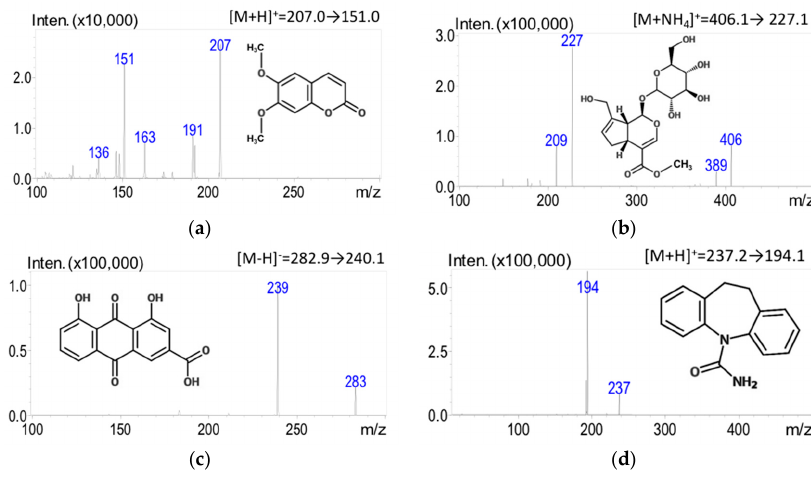
Figure 1. Chemical structures of the analytes and the product ion mass spectra and fragments of three marker compounds in YCHT and IS: ( a ) scoparone; ( b ) geniposide; ( c ) rhein; and ( d ) carbamazepine (IS). Table 1. Analytical LC-MS/MS conditions for the identification of the three marker constituents and carbamazepine.